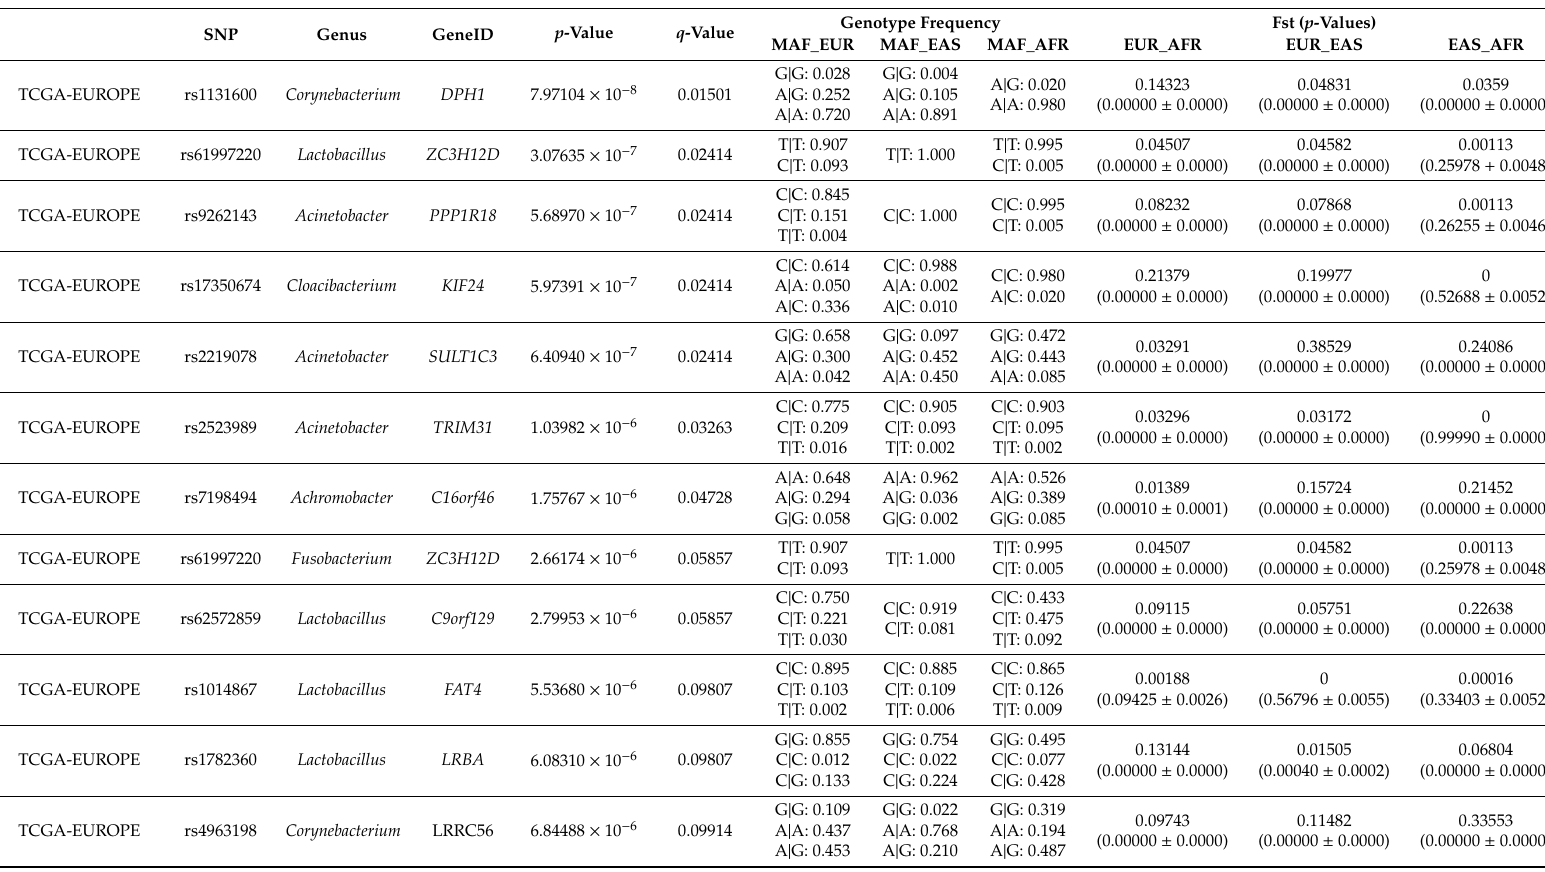
Table 1. Statistically significant ( q -value < 0.15) microbiome quantitative trait loci (miQTLs) in the TCGA-European and GTEx cohorts. No miQTLs were identified in the Asian